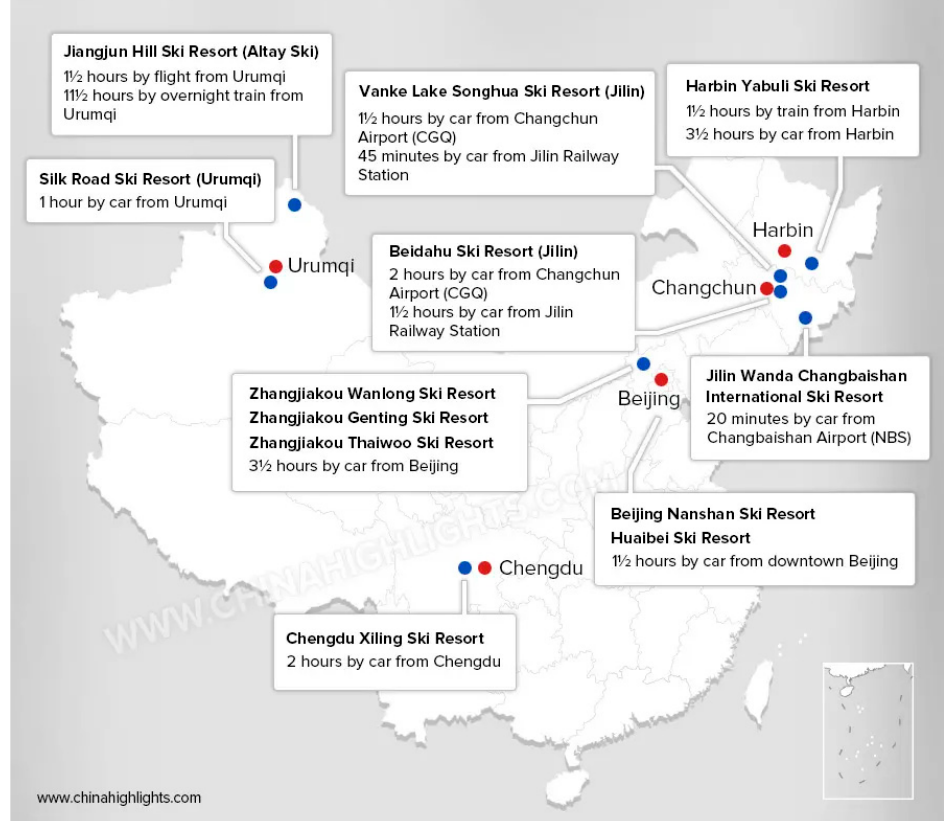
Figure 1. Selected ski resorts of blue dot and provincial captical city of red dot in China. (source: